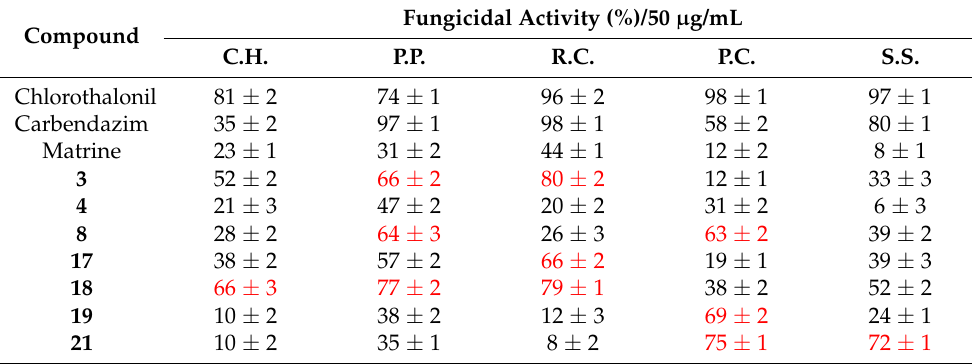
Table 2. Fungicidal activity of compounds against phytopathogens a